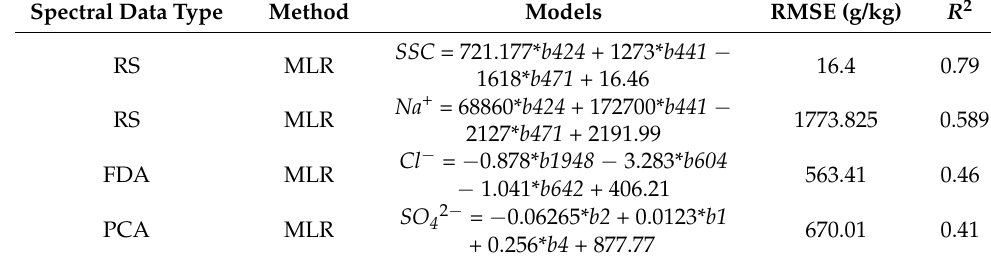
Table 4. The model expression and evaluation parameters of data transformation and modeling method for estimating the soil composition.